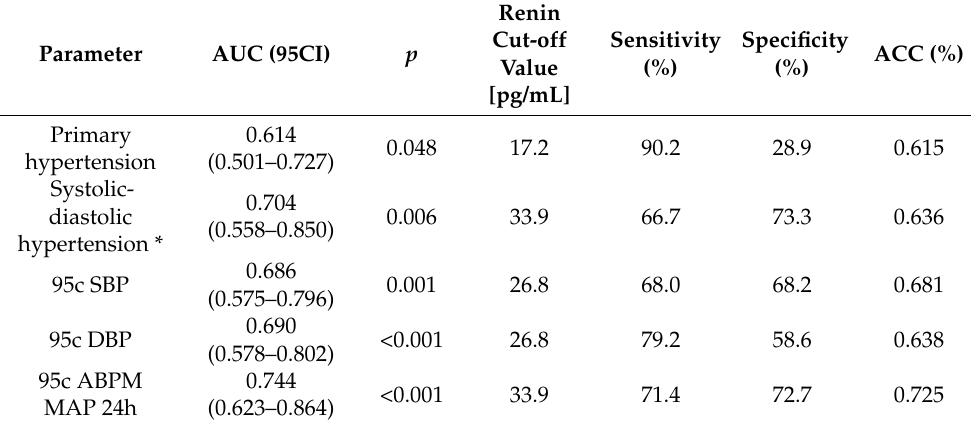
Table 5. Diagnostic accuracy of presence of primary hypertension, systolic-diastolic hypertension, and elevated office and ambulatory blood pressure to predict active renin concentration.